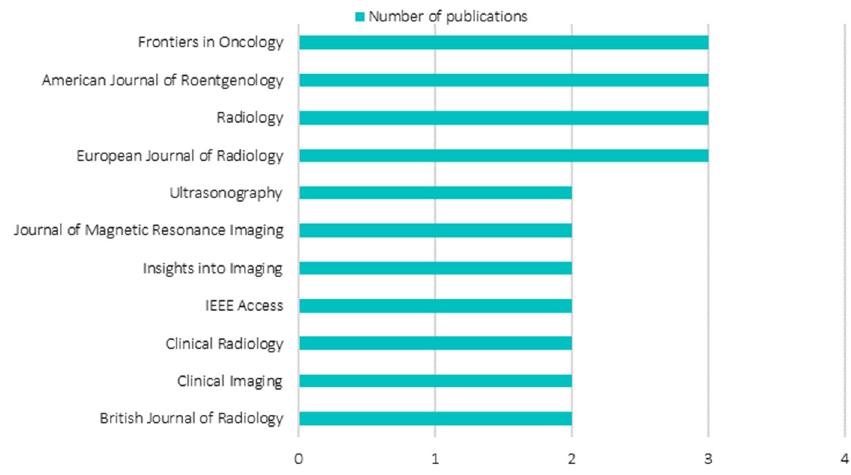
Figure 6. Analysis of most contributing journals.